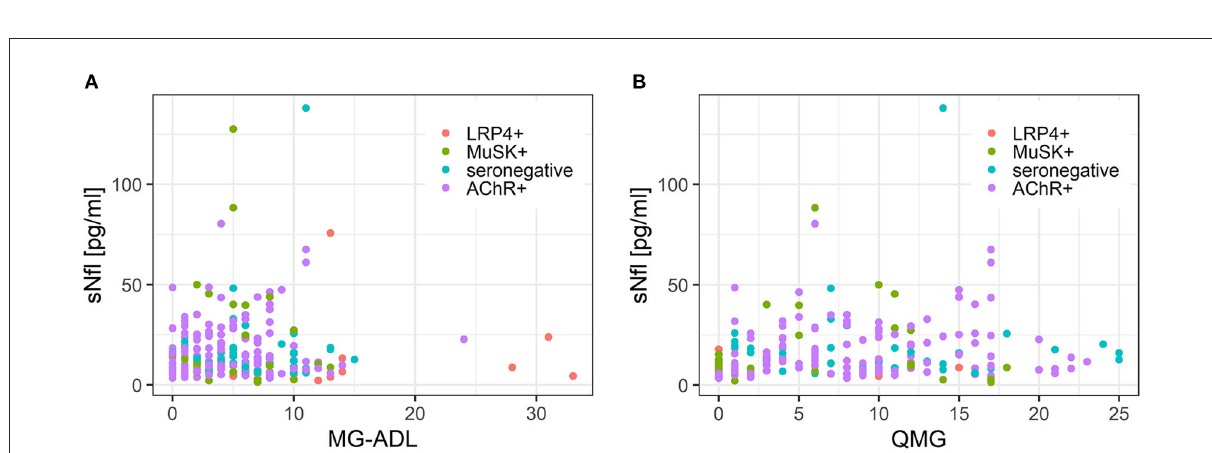
FIGURE4 (A) Scatterplot of the association between sNfl levels and disease severity measured with QMG score in MG subgroups. (B) Scatterplot of the association between sNfl levels and disease severity measured with MG-ADL score in MG subgroups. AChR- + , acetylcholine receptor antibody positive MG-patients, LRP4 + , lipoprotein related peptide 4 positive MG-patients, MuSK + , muscle specific positive MG patients, sNfl, serum neurofilament light chain, QMG, quantitative myasthenia gravis score, MG-ADL = myasthenia gravis activity of daily life score.